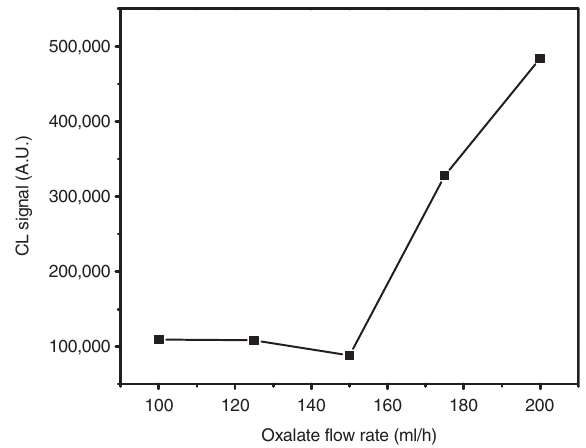
-Ru(bpy) 32 + NPs; Figure 7: The effect of analyte (oxalate) flow rate (ml/h) on CL signal 2 using diluted TiO -Ru(bpy) 33 + 2